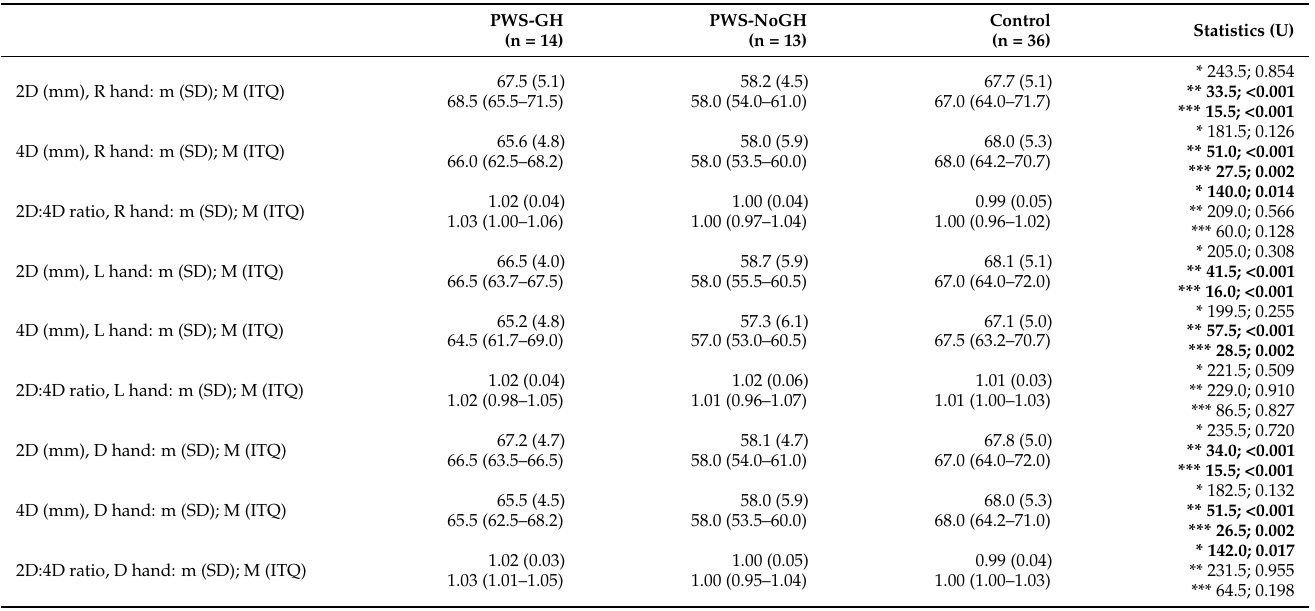
Table 5. Characteristics of digit measures between healthy control and PWS participants with and without GH treatment during childhood/adolescence. PWS-GH (n = 14)